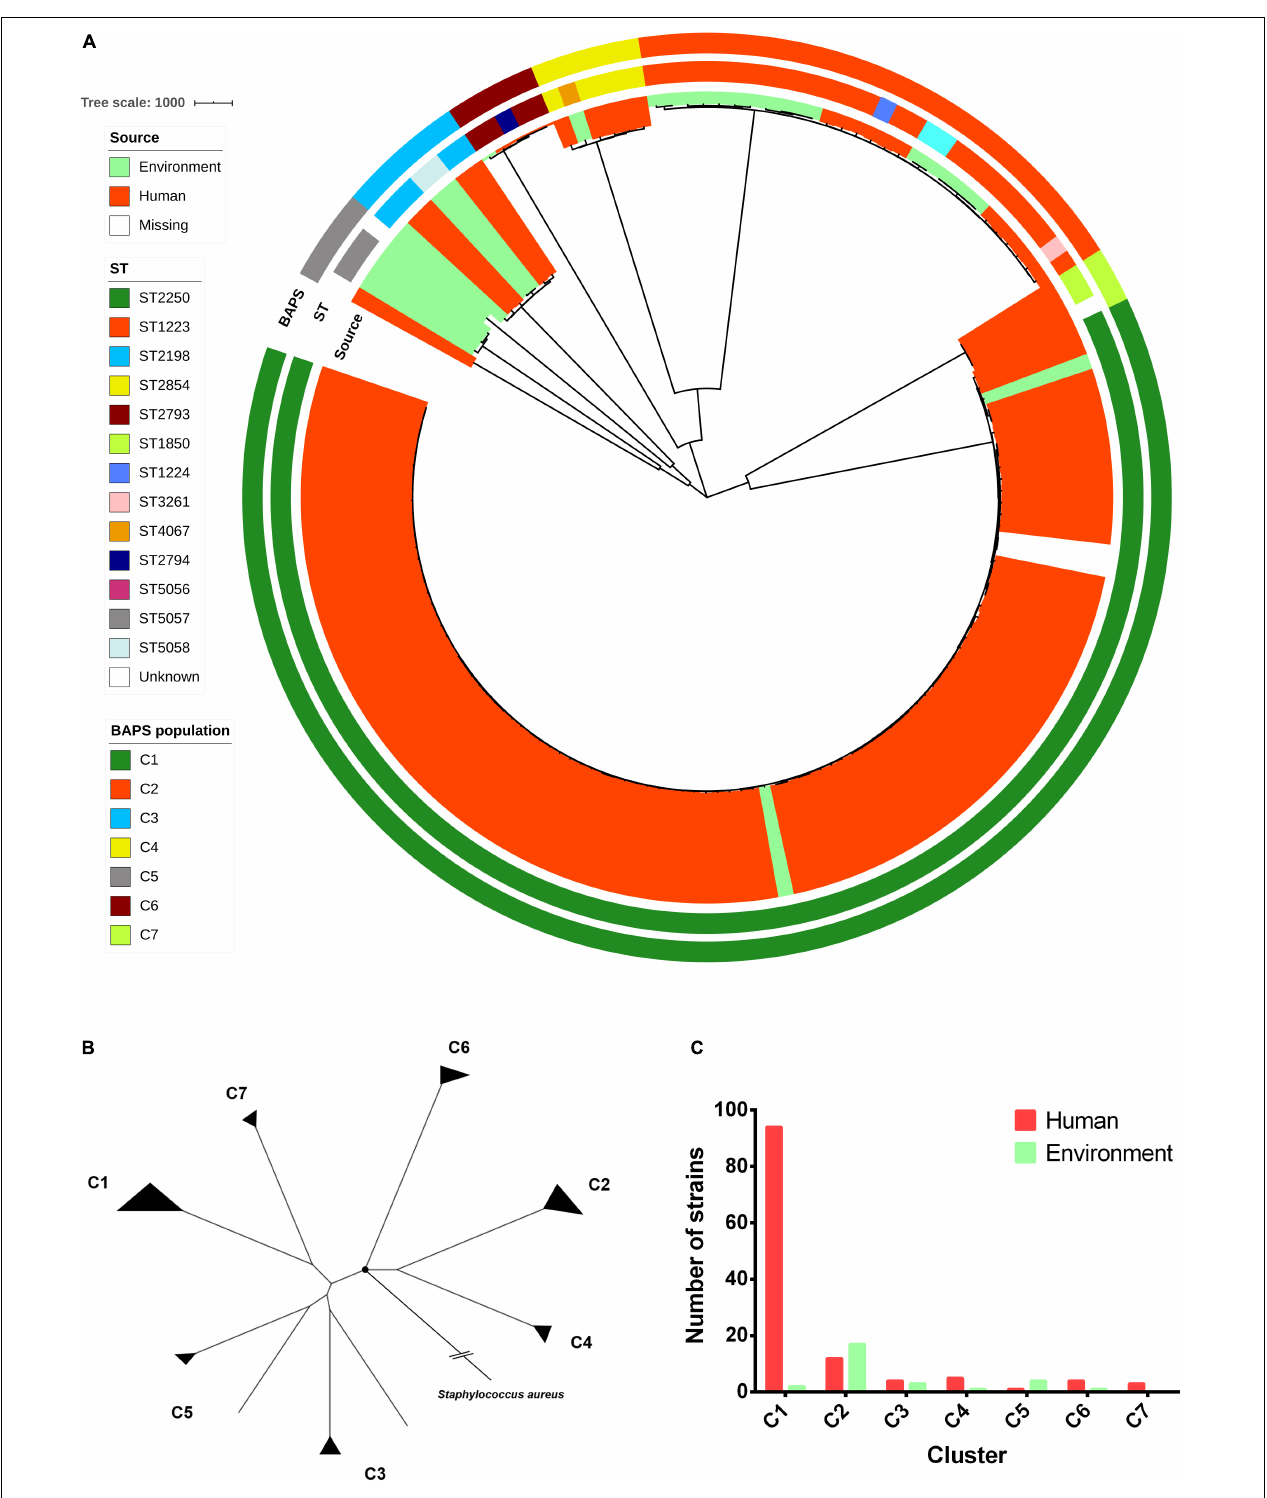
FIGURE 1 | Phylogenomic and population structure of Staphylococcus argenteus . (A) Maximum-likelihood (ML) tree of S . argenteus constructed from 37,309 core genome single-nucleotide polymorphisms (SNPs). The clade colors indicate the source of each strain. The inner bar color indicates the sequence type of each strain, and the outer bar color indicates the Bayesian analysis of population structure (BAPS) cluster to which each strain is attributed. (B) ML tree reconstructed from the core genome SNPs using S . aureus as an outgroup. The black circle indicates the root of the tree. (C) The number of non-clonal human and environmental strains in each